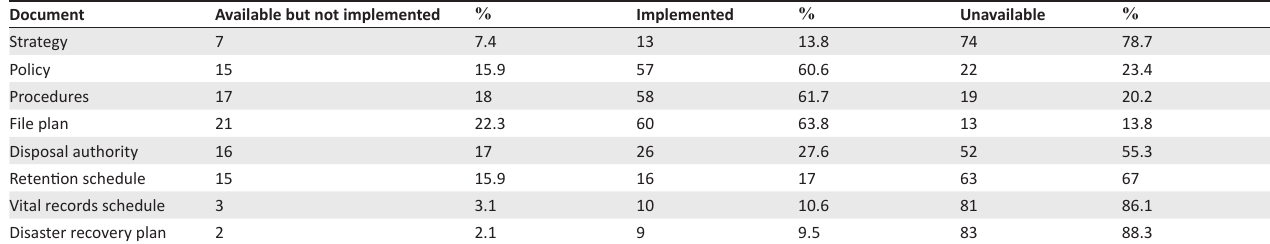
TABLE 1: Availability and implementation of key records management documents ( N =